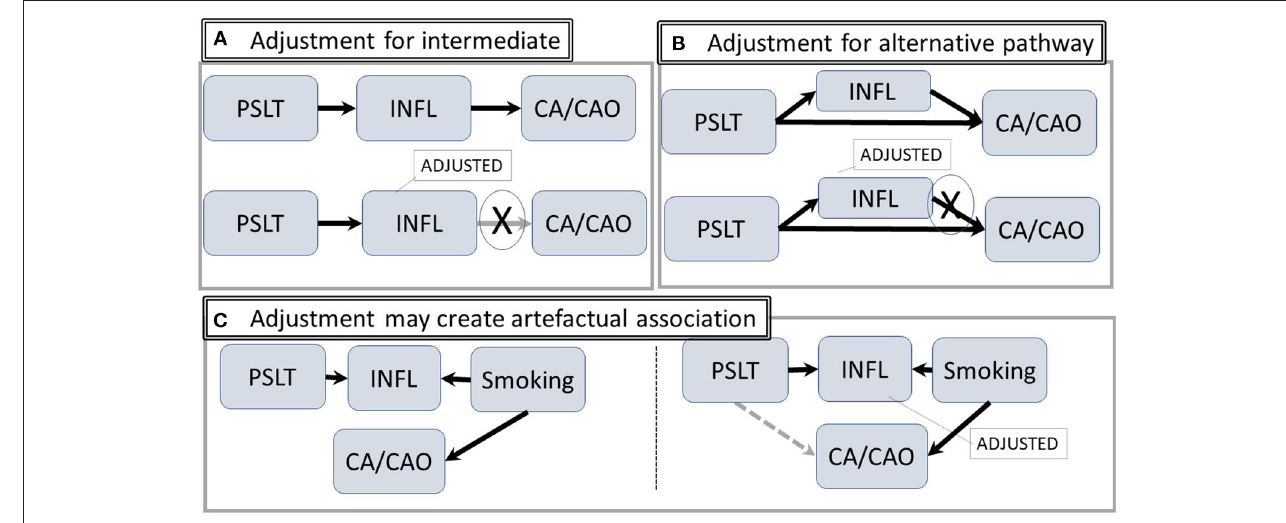
FIGURE 3 | Intermediate and alternative pathways. (A) The hypothetical pathway from PSLT to CA/CAO is mediated through inflammation. Statistical adjustment for inflammation may attenuate or block the pathway. (B) Inflammation is an alternative pathway from exposure to CA/CAO; adjustment for inflammation will potentially modify the apparent strength of the association. (C) There is no path from PSLT to CA/CAO. However, adjusting for inflammation may open an artifactual pathway from PSLT to CA/CAO (shown in gray) (Abbreviations are the same as in Figure 1 ).